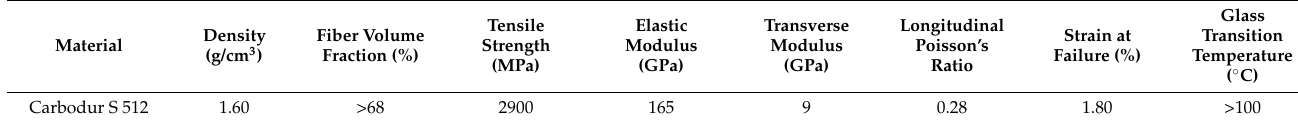
Table 2. Technical information of Sika Carbodur S 512, as reported in the PDS